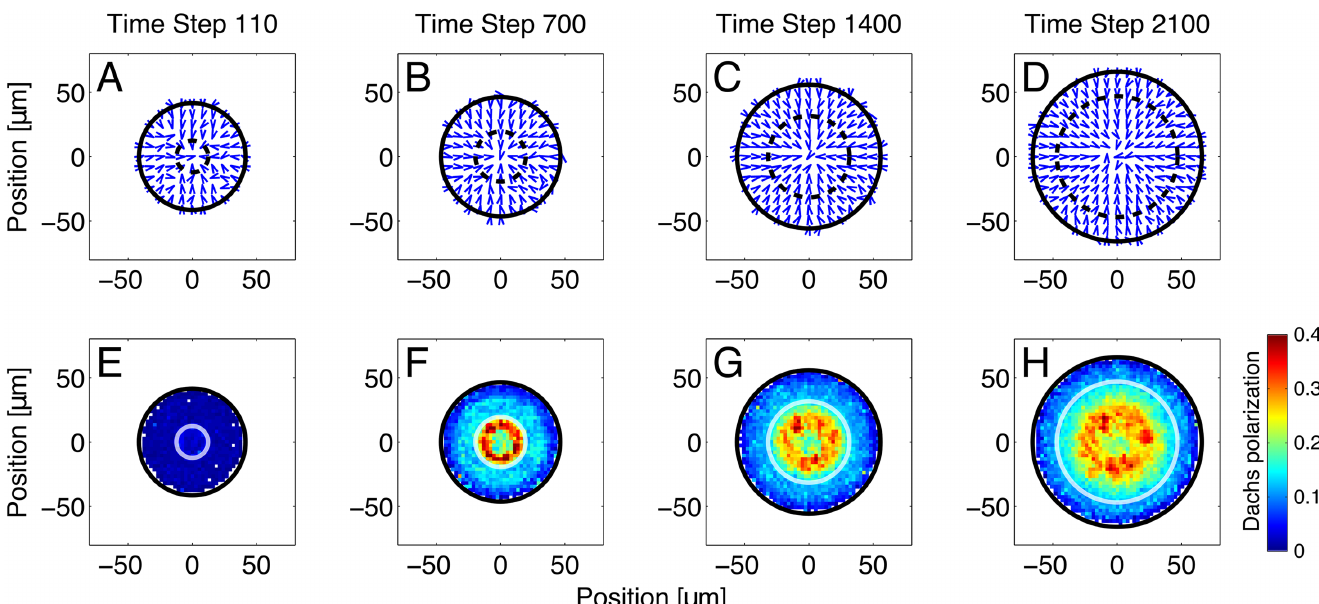
Fig 3. The Dachs polarization produced by our simulations of a moving front of Ds expression. Dachs polarizationreflects Ft-Ds bond asymmetry. The direction(panels A-D) and magnitude (panels E-H) of Dachs polarizationat 110 (A, E), 700 (B, F), 1400 (C, G) and 2100 (D, H) time steps (minutes) after the beginningof a single run are shown. (Becausethe simulationonly beginsto calculateDachs localization after time step 100 and records data every 10 time steps, we displaythe state of the disc at time step 110.) The arrows in panels A-D represent spatialaverages of cell polarization;they point to the side of the cell with the least amount of bound Ft. Panels E-H show the magnitude of Dachs polarizationin the wing disc; blue represents weaker polarization, red stronger polarization.Each dot representsthe Dachs polarization averagedover nearbycells. Dachs localization is a vector whose magnitude varies from zero, for an isotropic distribution of Dachs, to unity, if Dachs is all on one side. More details on simulatedDachs localizationare given in Section 6 of the Supplemental Text. The solid black circle is the approximate edge of the entire disc, while the dotted black circle (A-D) and white circle (E-H) represent the Ds expressionfront. This front moved radiallyoutwardover time, encompassing an increasingfraction of the wholedisc. Cells that had had this front pass over them (i.e., those inside the front) retainedtheir elevatedbond asymmetry for some time, leadingto Dachs polarization throughout the wing primordium that was elevatedcomparedto the hinge region. Note that cells within the Ds expressionfront tended to strongly favor havingtheir polarizationpoint inward;i.e., their bound Ft was predominantlyon the outer (proximal)side, consistent with the localization of Dachs observedexperimentally [7, 8, 26, 48]. Cells outsidethe front had weaker and less consistent Dachs localization.The Dachs localization in this outer regionwas primarily due to the Fj gradient. (S15 Fig in the Supporting Information shows similarlyweak polarizationwhen Ds is